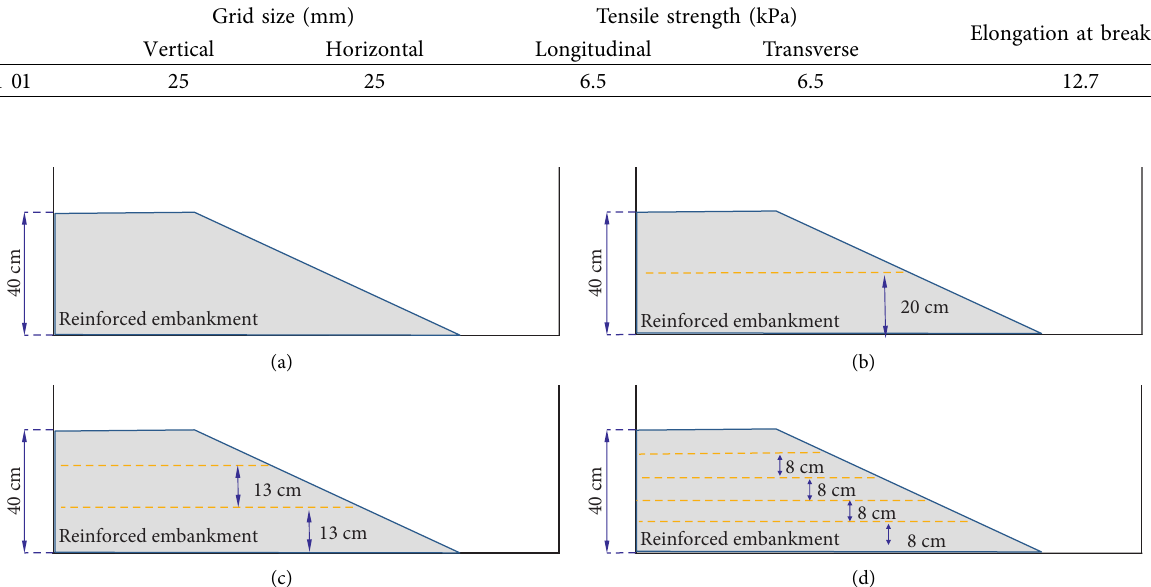
Figure 2: The schematic diagram of reinforcement layers: (a) N � 0; (b) N � 1; (c) N � 2; (d) N �